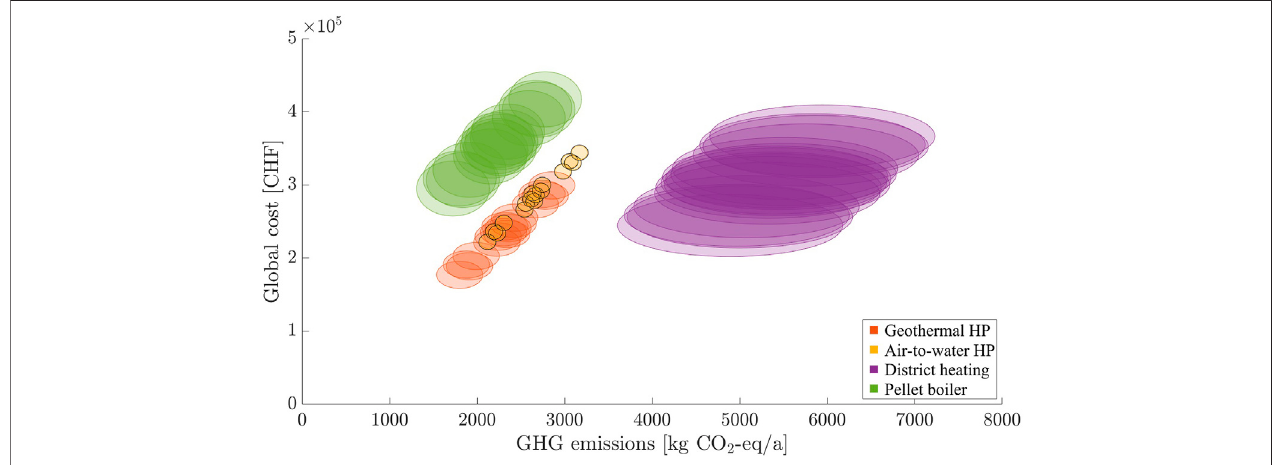
FIGURE 8 | Uncertainty ranges illustrated in the context of energy consumption and its implications on cost and GHG emissions.